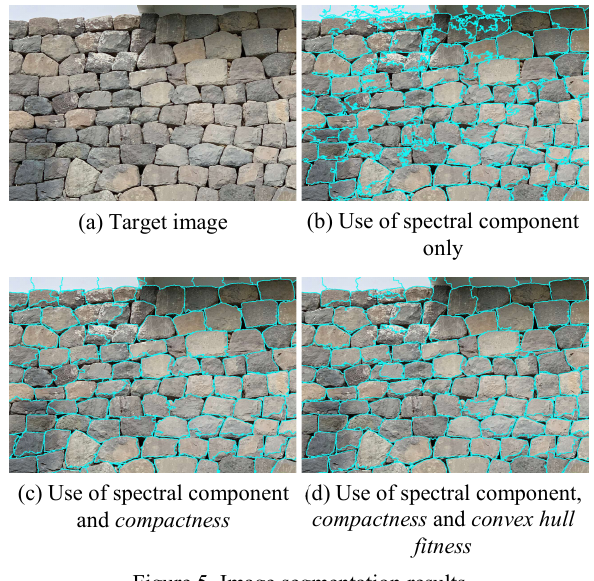
Figure 5. Image segmentation